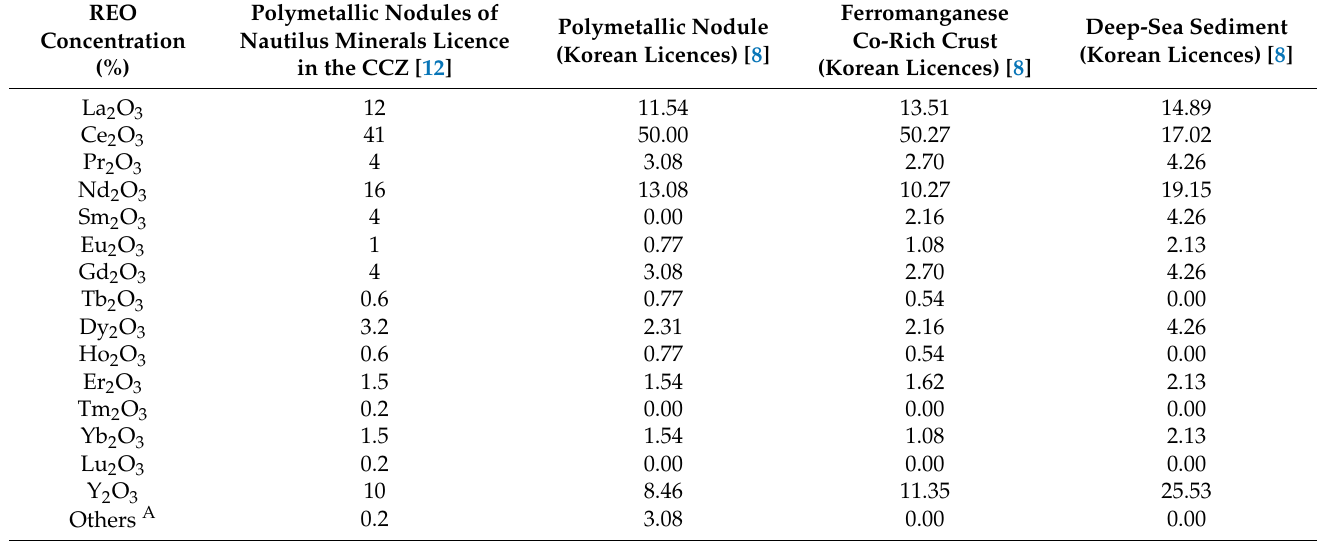
Table 5. REO relative split (%) from deep-sea deposits (polymetallic nodules, Fe–Mn Co-rich crusts and deep-sea sediments